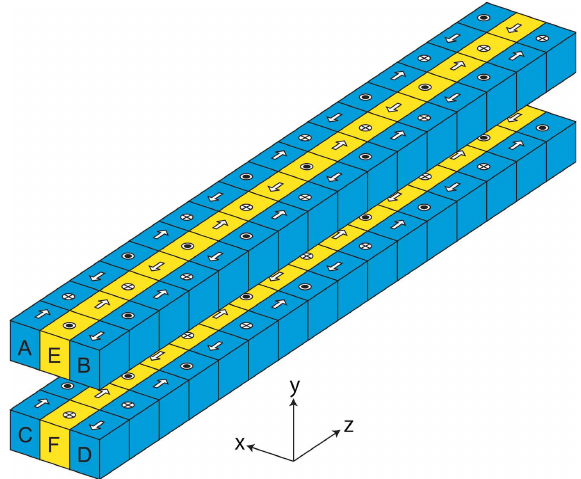
Figure 1 Schematic drawing of a helical undulator composed of six Halbach arrays. The definition of the coordinate system in this paper is shown for